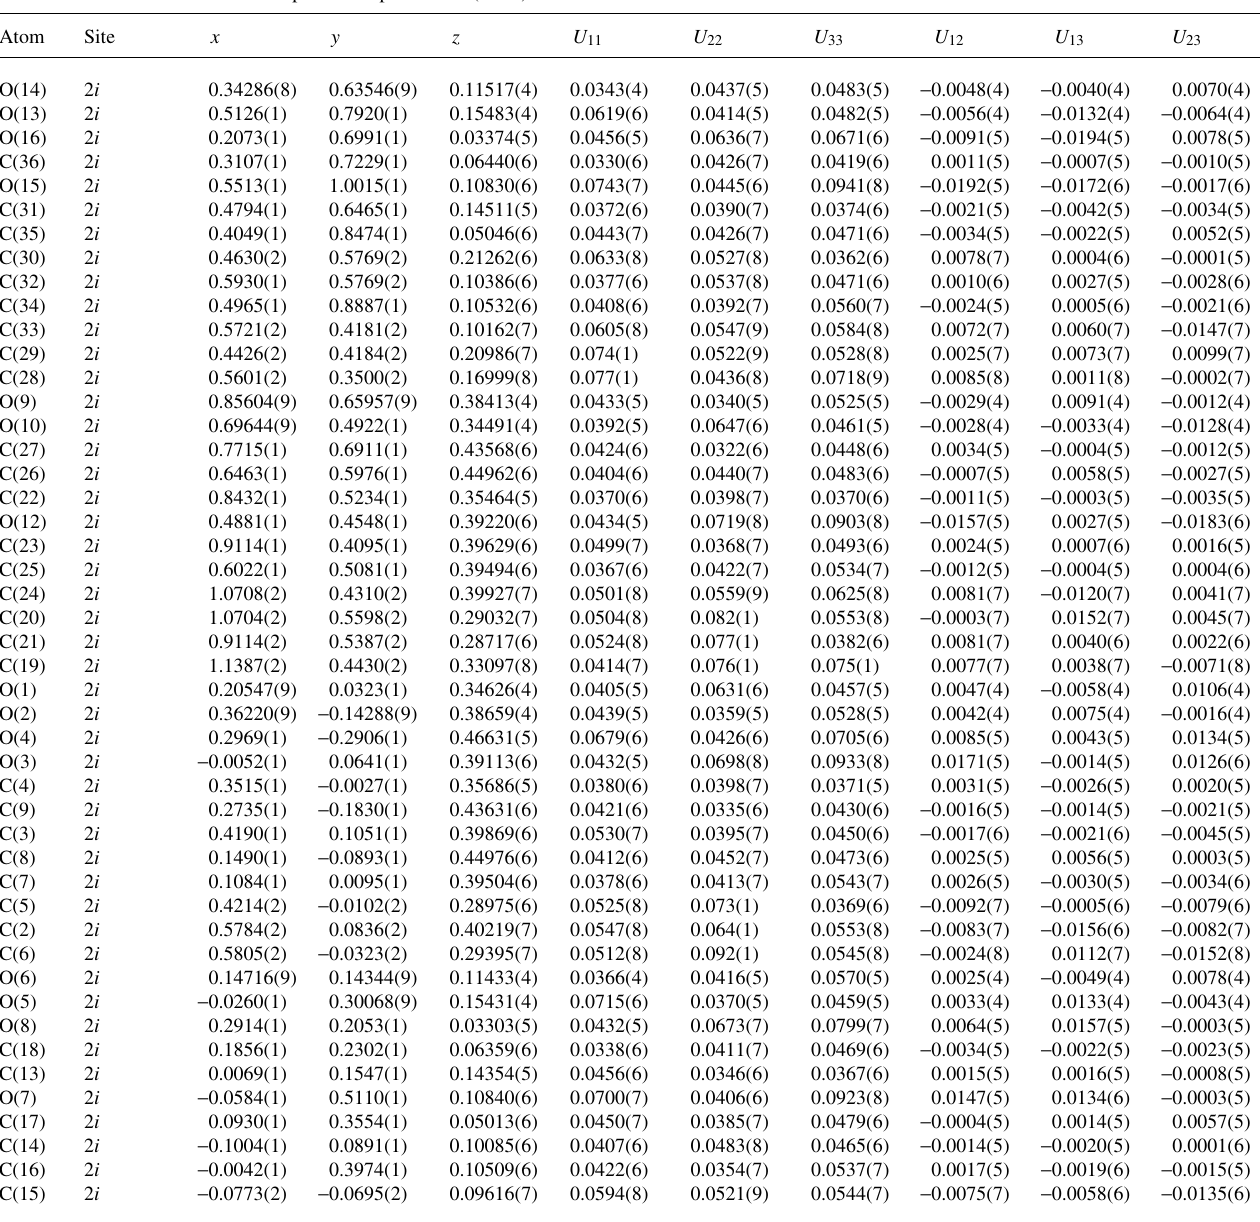
Table 3. Atomic coordinates and displacement parameters (in Å 2 )